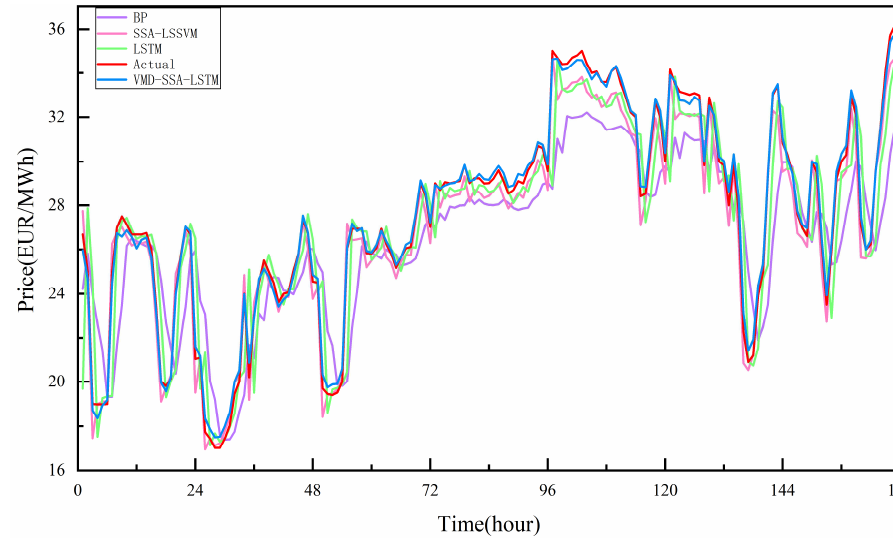
Figure 10. Curve of spring forecast results for Spain.